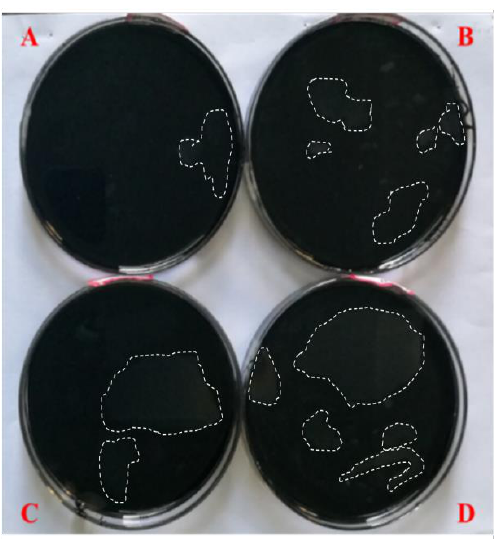
Figure 3. Water solutions’ appearance after 7 days immersion ( A ) distilled water; ( B ) 10% NaCl salt solution; ( C ) pH3 acid solution; ( D ) pH11 alkali solution.